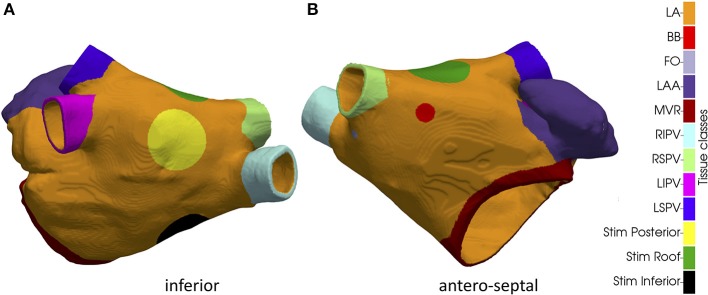
Inferior (A) and antero-septal (B) aspect of the anatomical model with tissue classes. LA bulk, Bachmann's bundle insertion point (BB), fossa ovalis (FO), left atrial appendage (LAA), mitral valve ring (MVR), right inferior pulmonary vein (RIPV), right superior pulmonary vein (RSPV), left inferior pulmonary vein (LIPV) left superior pulmonary vein (LSPV). The three circular regions in which the extra stimuli were applied to initiate reentry in the three simulated AF scenarios are indicated as well.